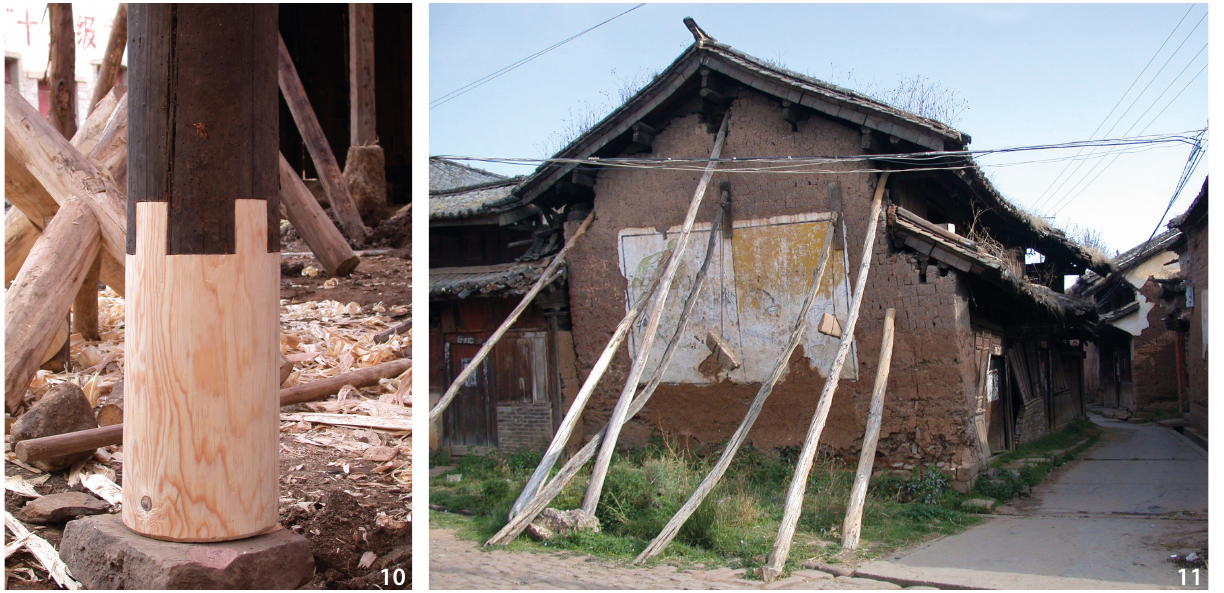
Figure 10 Example of wooden pillar restoration in Shaxi (Source: the author). Figure 11 Portrait of Red Army on the wall of old building called ‘Test building“ by local people (Source: the